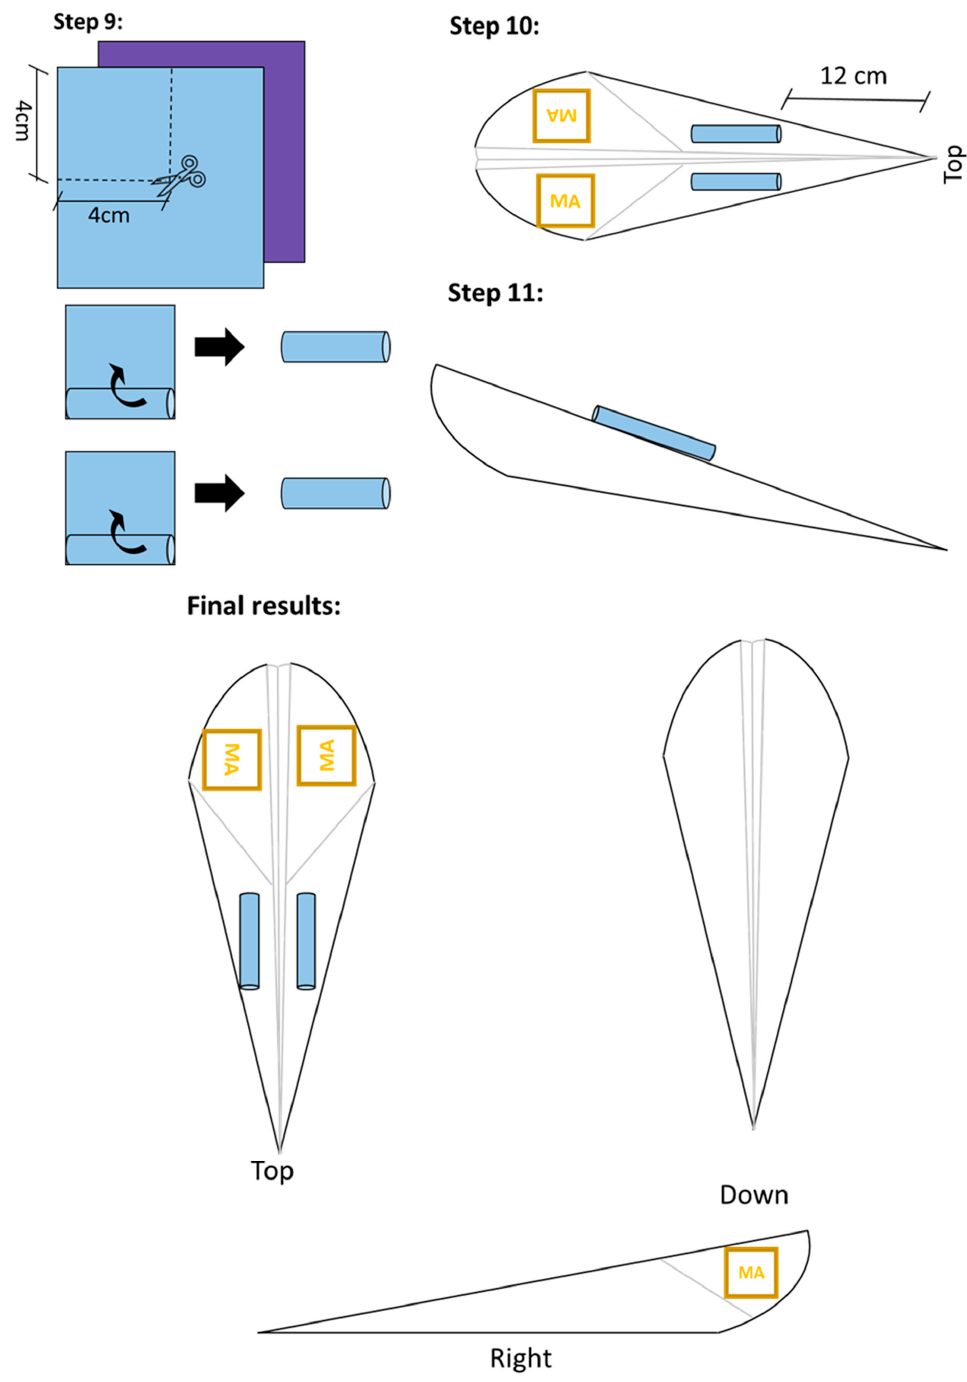
Figure 7. Paper plane drawing—Part 3.